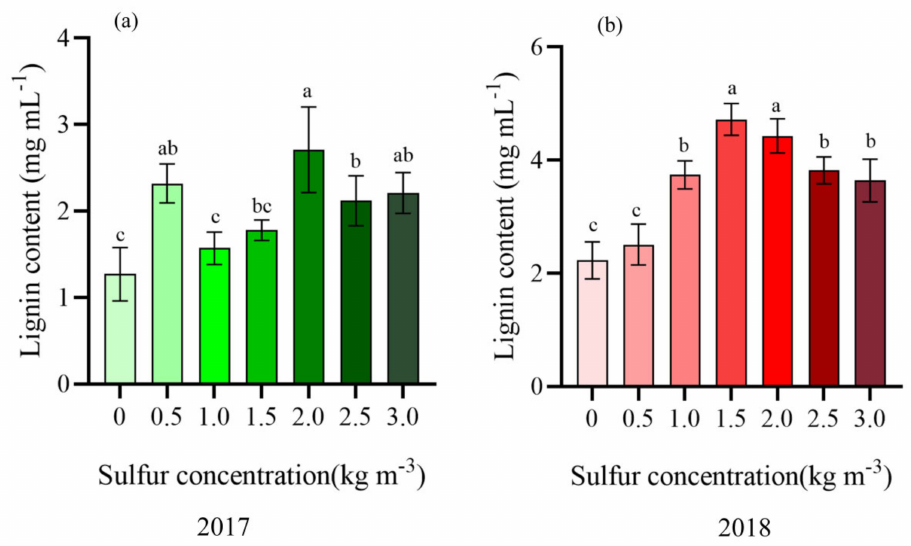
Figure 7. Effects of different sulfur concentration on lignin content in the stems of kiwifruit. Different letters indicate significant difference between means at p < 0.05. Value are means ± SE (n = 3). ( a ) Lignin content in kiwifruit stem in 2017; ( b ) Lignin content in kiwifruit stem in